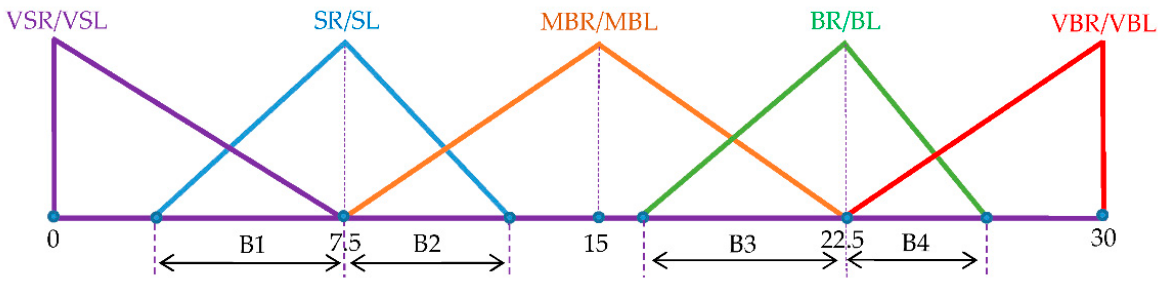
Figure 12. The output membership functions used for the Mohammadian-based FLC_GA.